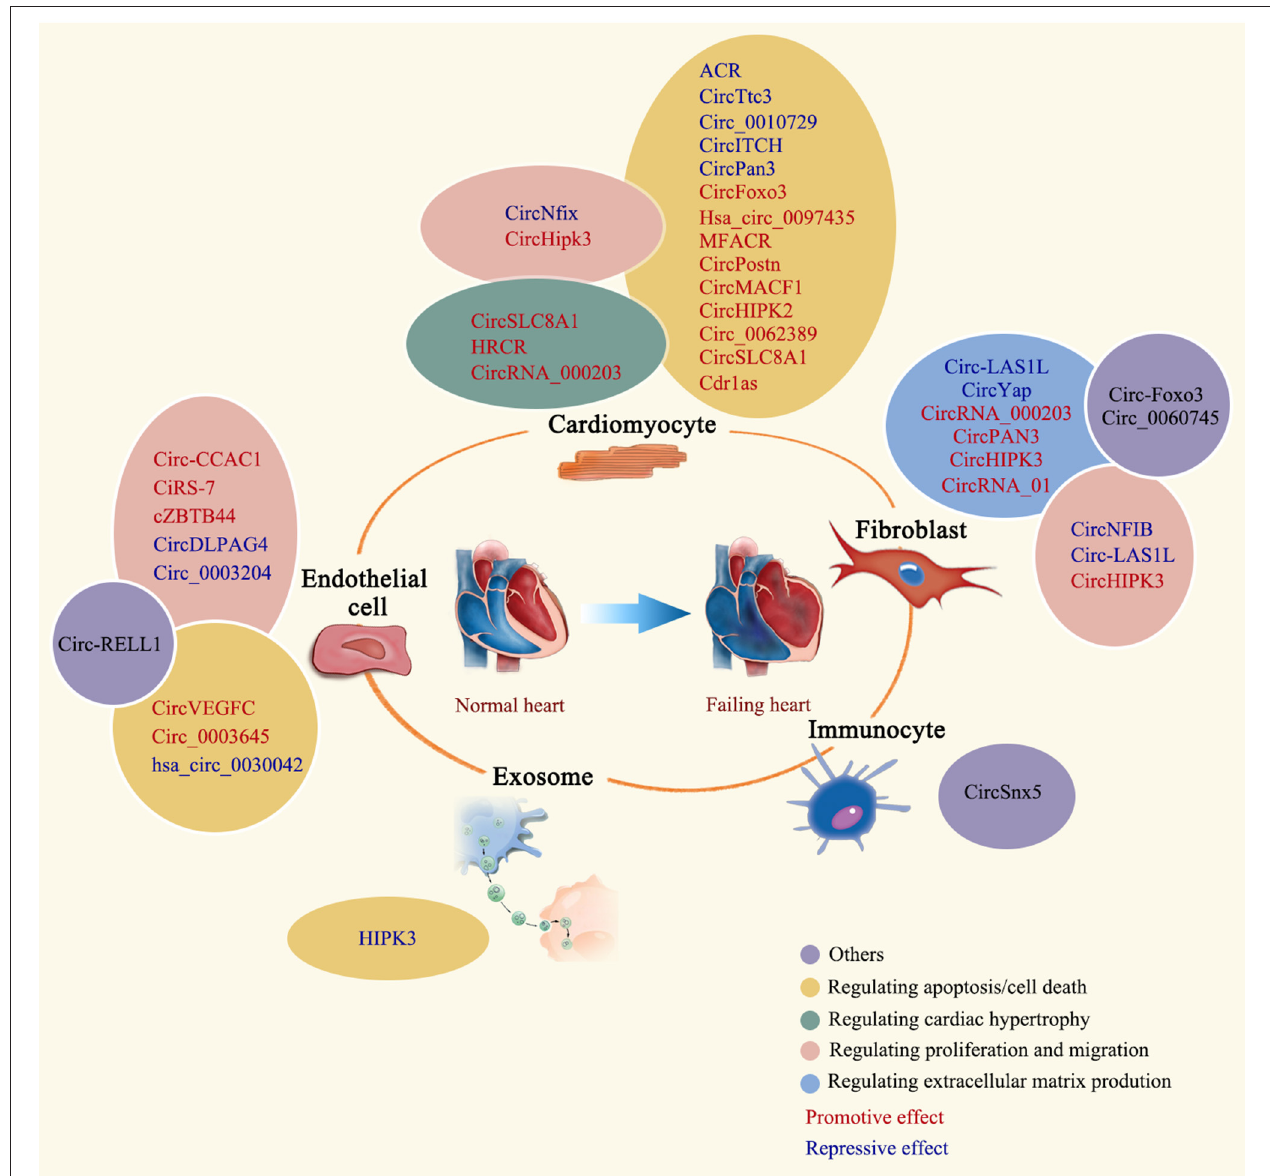
FIGURE 3 | Regulatory roles of circRNAs in cardiac remodeling. The regulatory role of summarized circRNAs is indicated by colored ovals. CircRNAs are labeled in different colors to indicate the promotive or repressive function.